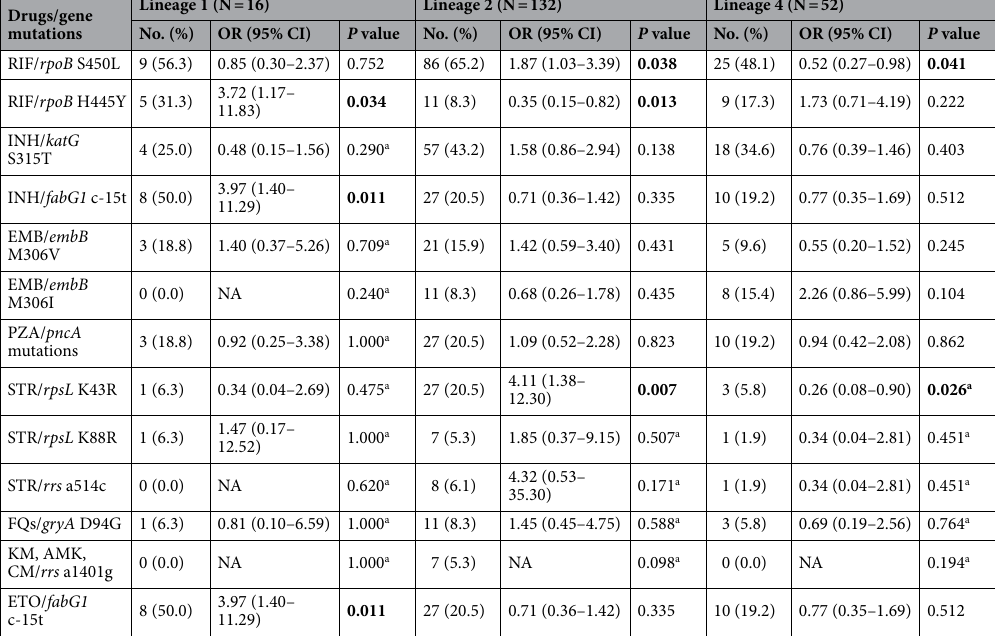
Table 4. Profiles of drug-resistant mutations in lineage 1, lineage 2 and lineage 4 isolates. Statistical significances are represented in bold. RIF rifampicin, INH isoniazid, EMB ethambutol, PZA pyrazinamide, STR streptomycin, FQs fluoroquinolones, KM kanamycin, AMK amikacin, CM capreomycin, ETO ethionamide, OR odds ratio, CI confidence interval, NA not applicable due to a small no. of cases. a Fisher’s exact probability test